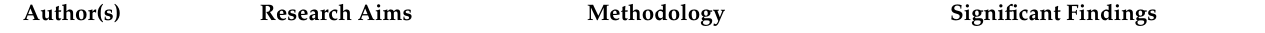
Table 3. Review of key literature for other infectious diseases